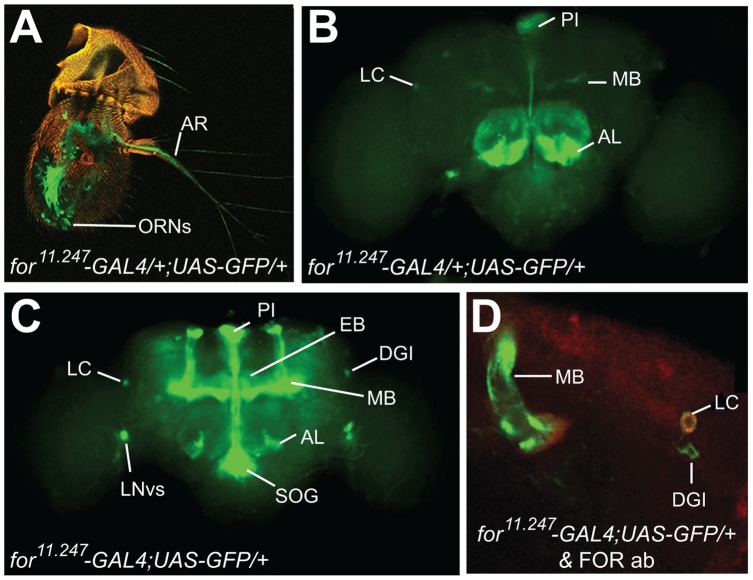
Expression pattern of for11.247-GAL4.
A, B) Expression of for11.247-GAL4/+;UAS-GFP/+ flies. A) In the antenna, GFP (green) was expressed in the arista (AR) and a sub-population of olfactory receptor neurons (ORNs) in the third antennal segment. B) In the CNS, GFP was expressed in specific glomeruli in the antennal lobe (AL), par intercrebalis (PI) neurons, and weakly in the mushroom body (MB) and lateral cells (LC). C) In for11.247-GAL4;UAS-GFP/+ flies strong GFP expression was seen in MB, PIs, LC and sub-oesophageal ganglion (SOG), as well as the ventral lateral neurons (LNvs), the giant dorsal interneuron (DGI), parts of the antennal lobe (AL) and ellipsoid body (EB). D) Higher magnification of for11.247-GAL4;UAS-GFP/+ flies showing partial co-localization with a FOR antibody (red) in the MB and LC, but not in DGI.